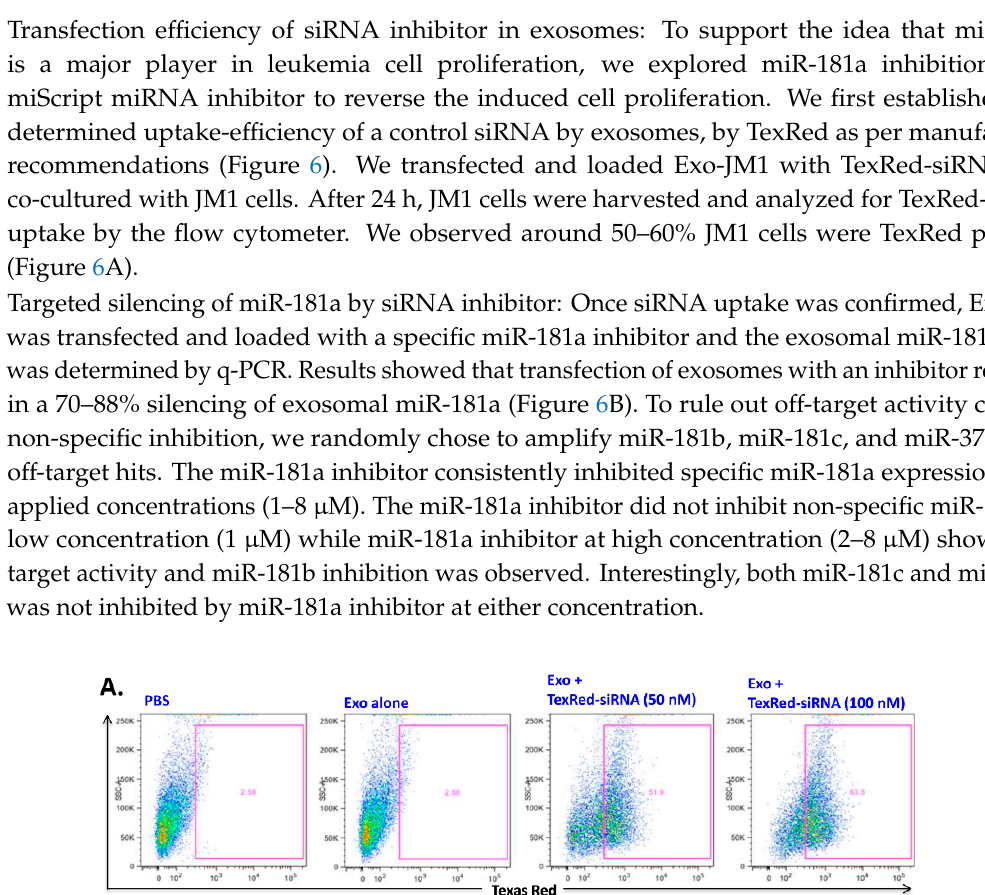
compared to diagnosis (D1). ( E ) Expression of miR-181a-5p by q-PCR in Exo-CM of ALL cell lines